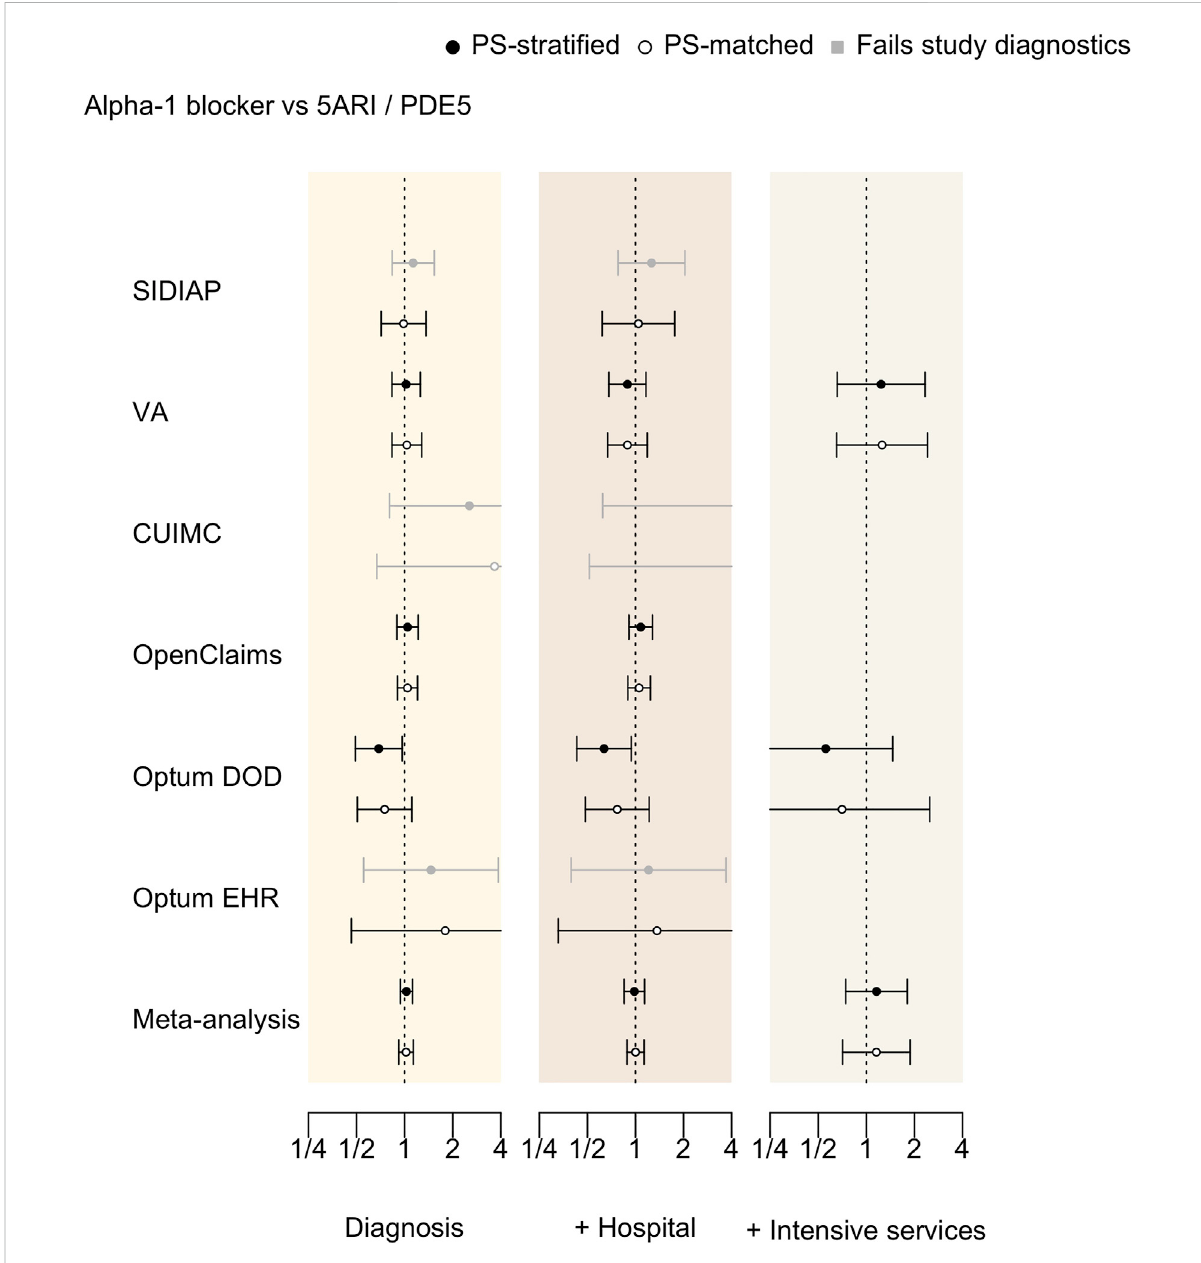
FIGURE 3 Hazard ratios of COVID-19 outcomes between alpha-1 blocker and 5ARI/PDE5 prevalent-use across data sources. The outcomes are COVID- 19 diagnosis (Diagnosis), COVID-19 hospitalization (+Hospitalization), and COVID-19 hospitalization requiring intensive services